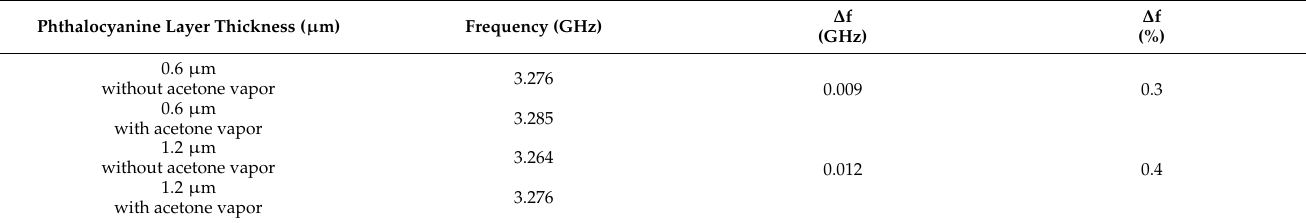
Table 2. Measured frequency shifts depending on the sensitive phthalocyanine layer’s